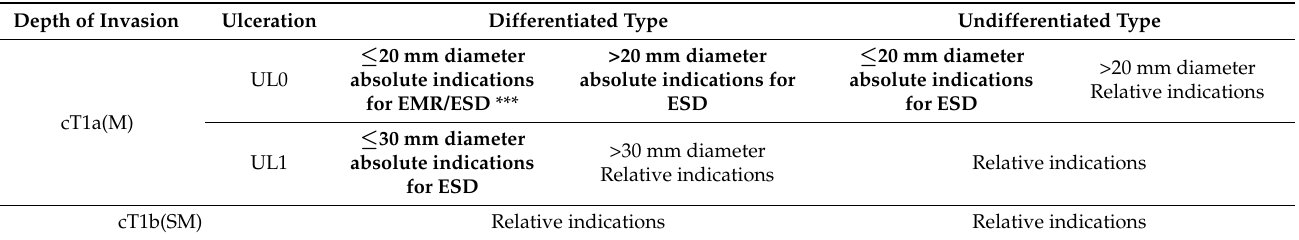
Table 1. Indications of endoscopic resection of gastric cancer * ,